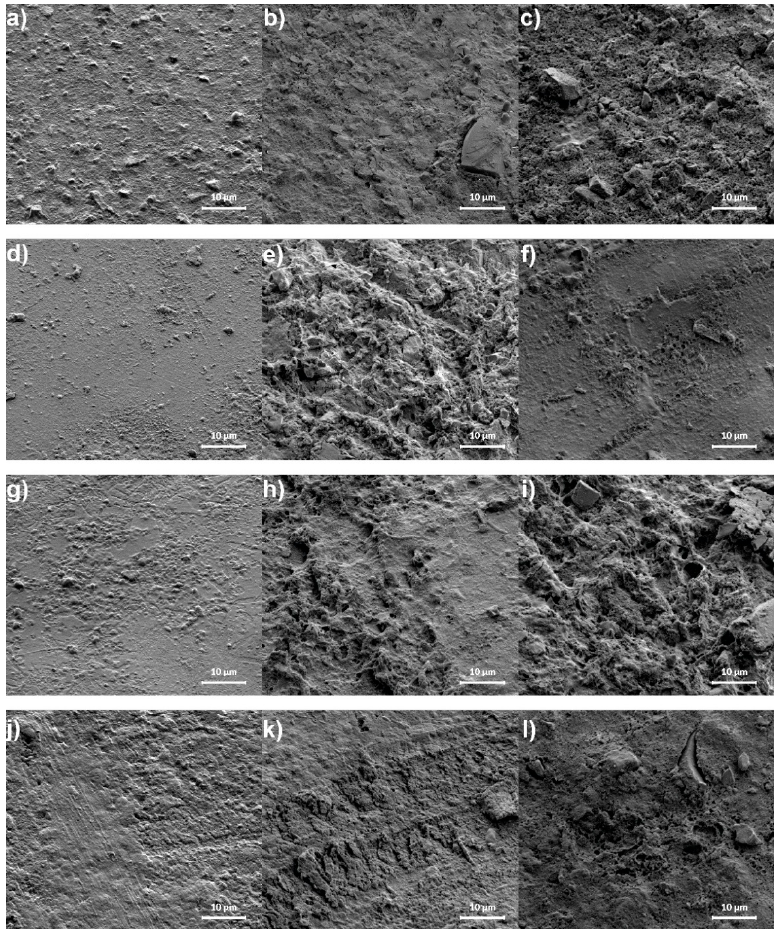
Figure 2. SEM micrographs of Arkona ( a – c ), Helioseal F ( d – f ), Conseal ( g – i ) and Helioseal F Plus ( j – l ) before, after release in deionized water and after release in saline solution, respectively. The study was performed for one randomly selected sample of each material: Arkona; Conseal F; Heli- oseal F; Helioseal F Plus.